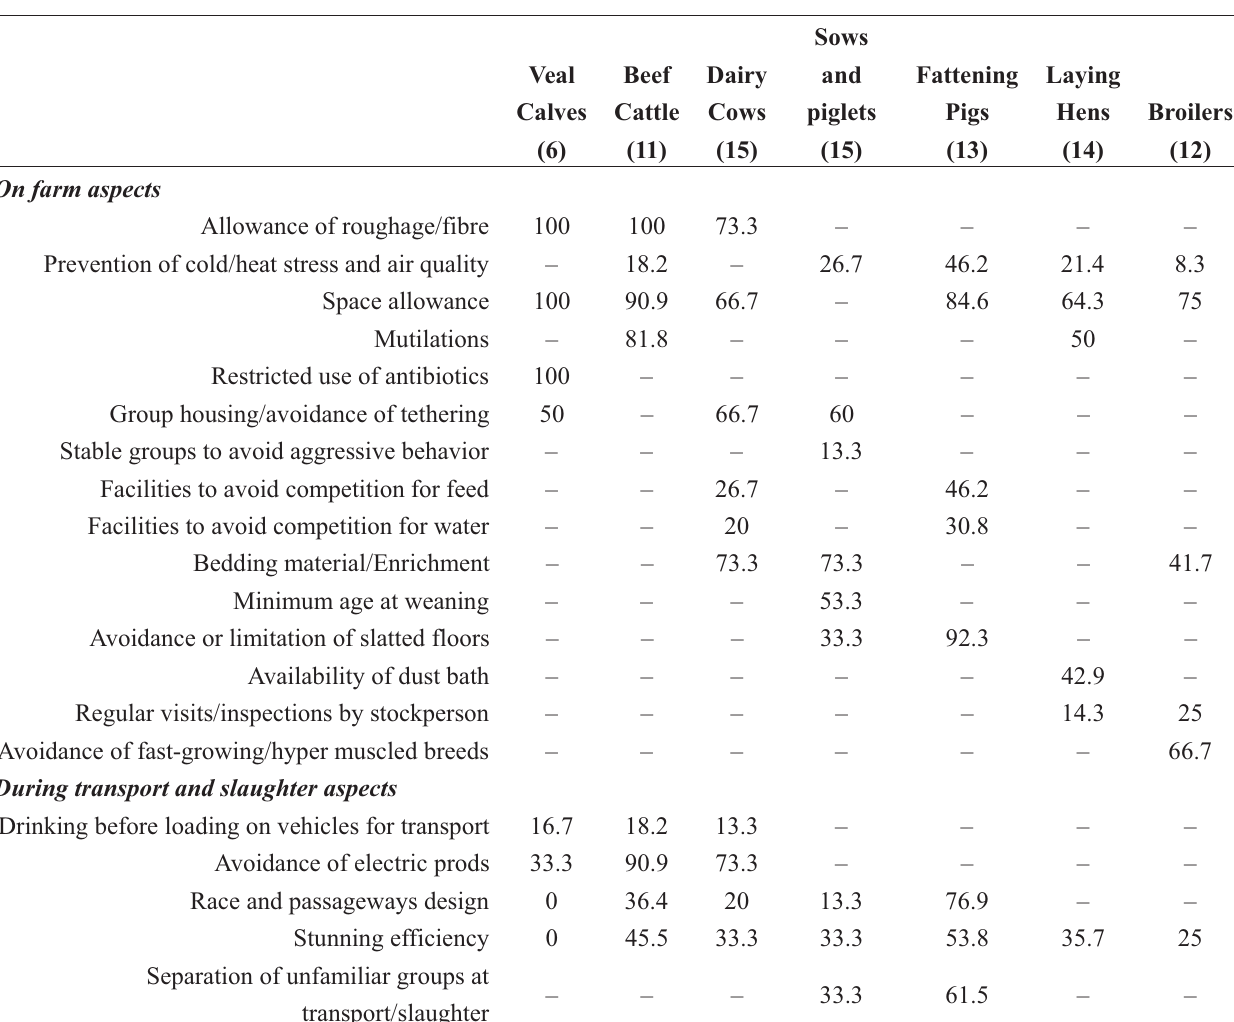
Table 8. Percentage of standards and initiatives that include aspects that go beyond current EU legislation, and that are relevant for the welfare of each species/category of farmed animals (according to expert assessment using the Welfare Quality ® principles).